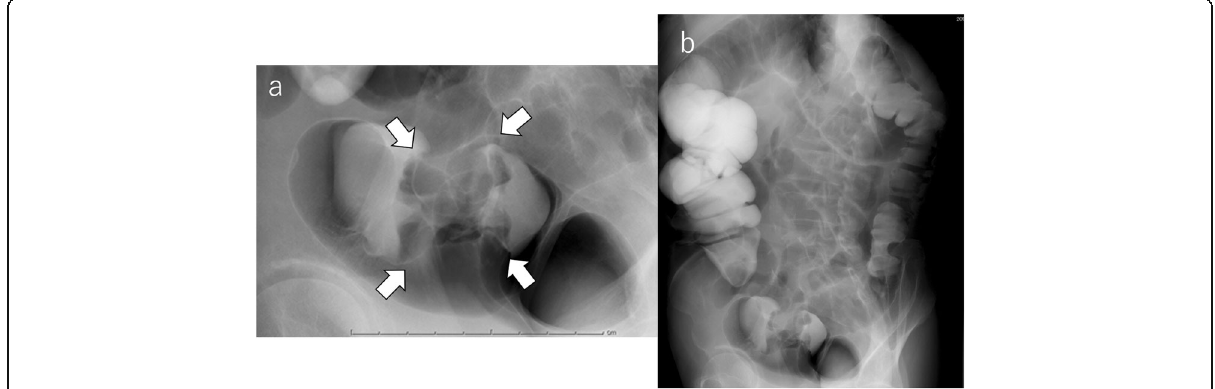
Fig. 2 Barium enema examination showed a tumor measuring 45 mm in diameter at the rectosigmoid colon ( a , arrow). No other colorectal lesions were observed ( b